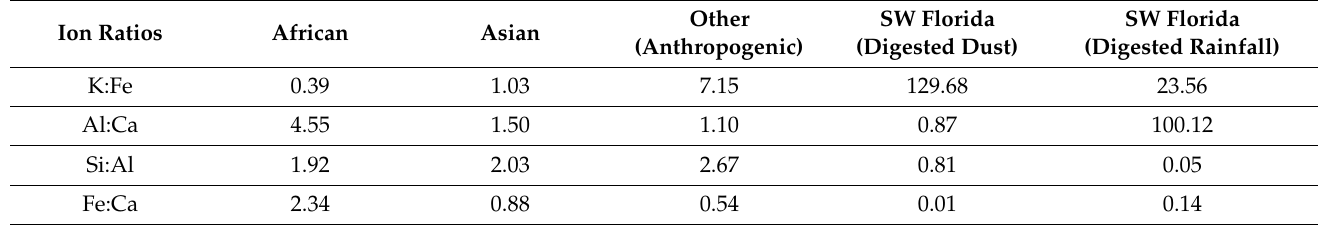
Table 4. The ratios of K:Fe, AL:Ca, Si:Al, and Fe:Ca pertaining to the three categories of fine dust sources (African, Asian, and Other) measured at the EVER1 station in South Florida [6] compared to the composition ratios for the digested dust and digested rainfall in SW Florida (this